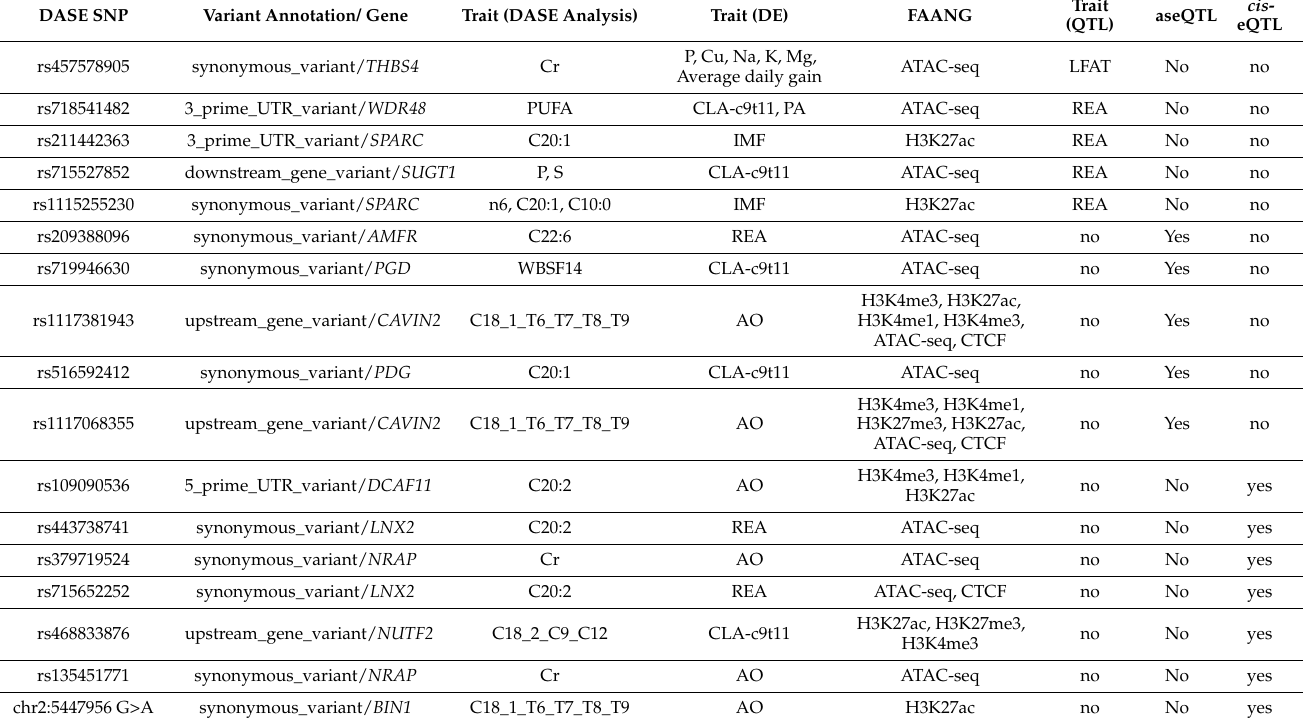
Table 2. DASE SNPs located in DEGs which overlapped epigenetic data and putative regulatory